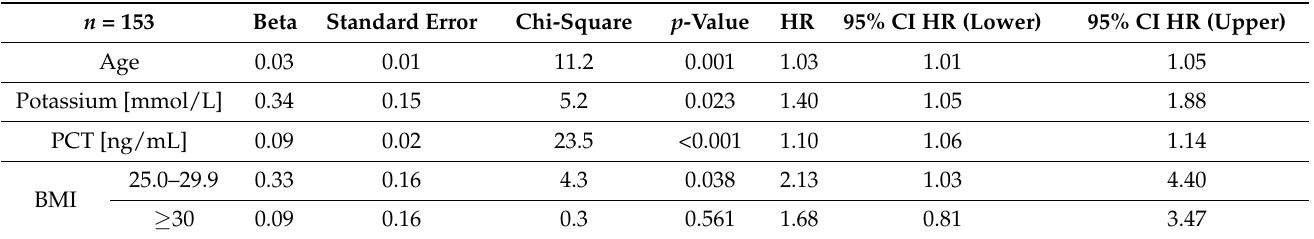
Table 9. Assessment of the influence of variables on mortality: the Cox proportional hazards regression model, a multivariate model. n =